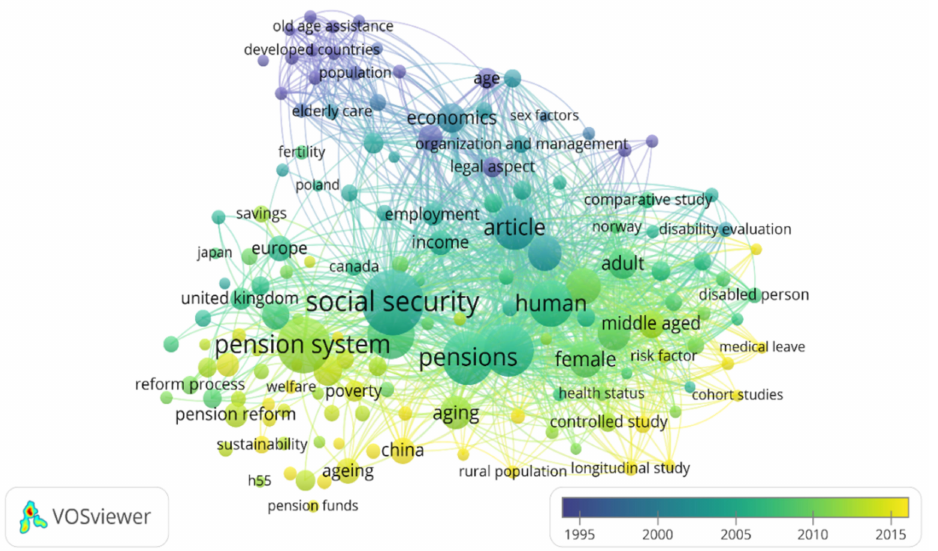
Figure 9. Evolution of the main keywords network based on co-occurrence (1936–2021). Source: own elaboration.